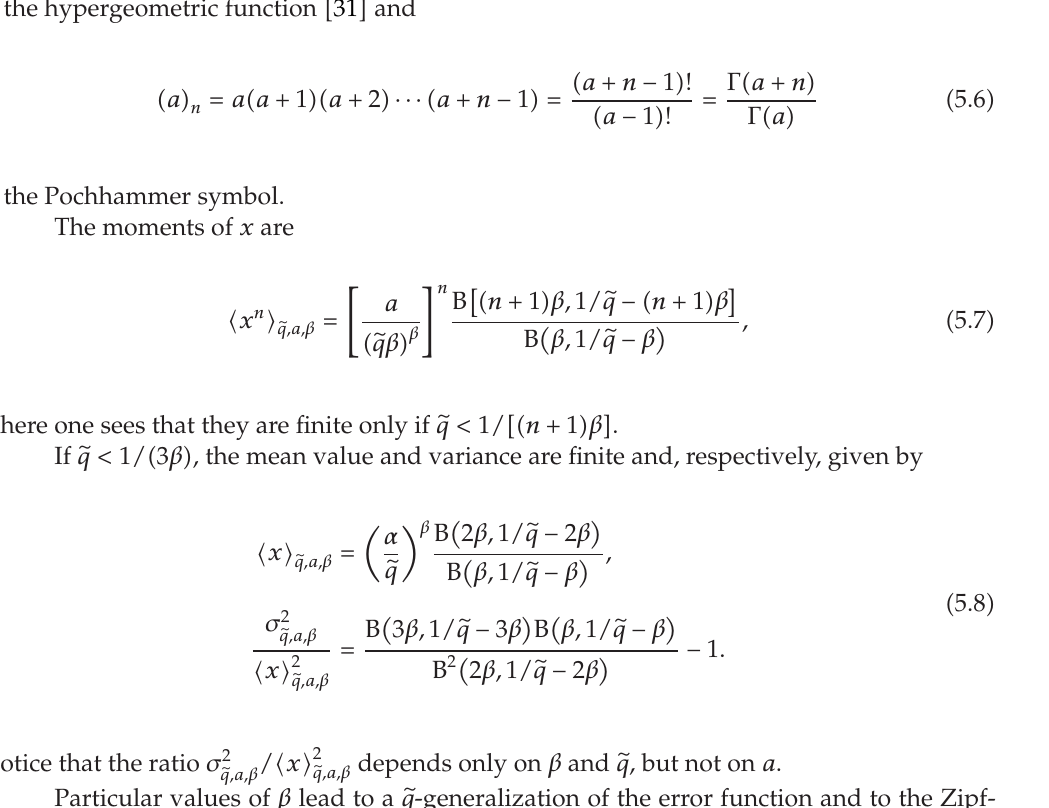
is the hypergeometric function (cid:4) 31 (cid:5) and